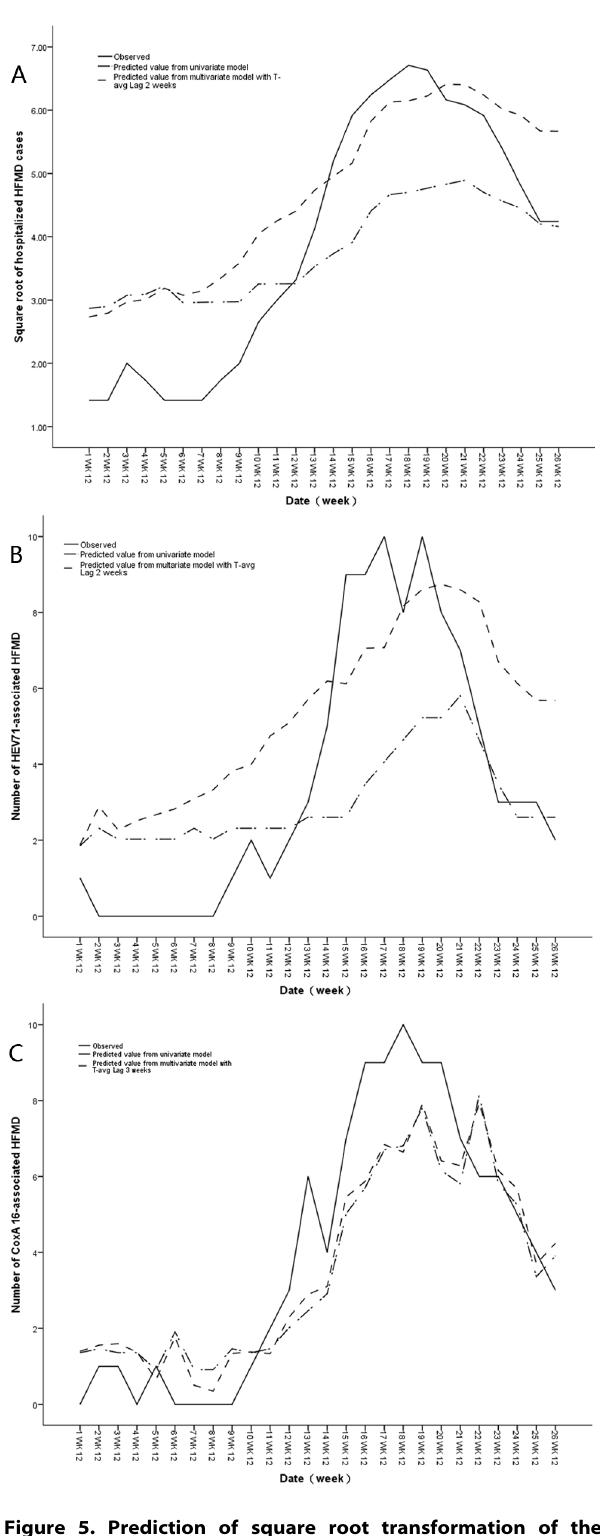
Figure 5. Prediction of square root transformation of the number of HFMD hospitalizations, the number of HEV71- associated and CoxA16-associated HFMD hospitalizations on the basis of a seasonal autoregressive integrated moving average model (SARIMA) model with average atmospheric temperature as the covariate for 2012. Solid line: observed values during the period, dashed line: predicted values for 2012 with and without climatic variables. A: Square root transformation of the number